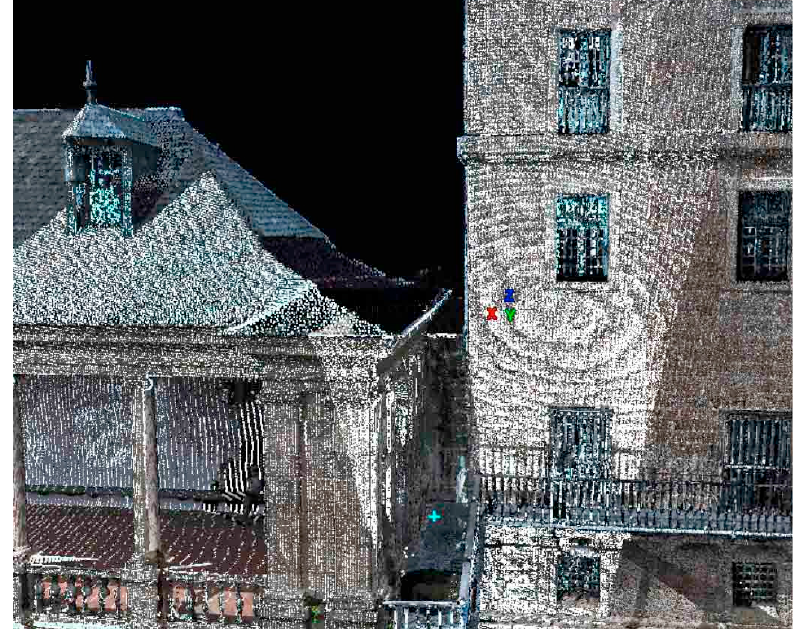
Figure 7. Detail of the point cloud of the pitched roof at the east front of the Galería de Convalecientes , as registered using Leica Cyclone program. Scan process made by a Leica P40 in RGB and referenced to a local coordinate system.